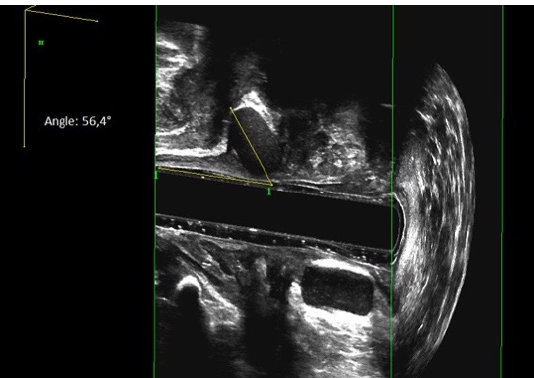
Figure 5. 3D-endoanal ultrasound image: A migrated prosthesis in a 56.4° angle to the anal canal.